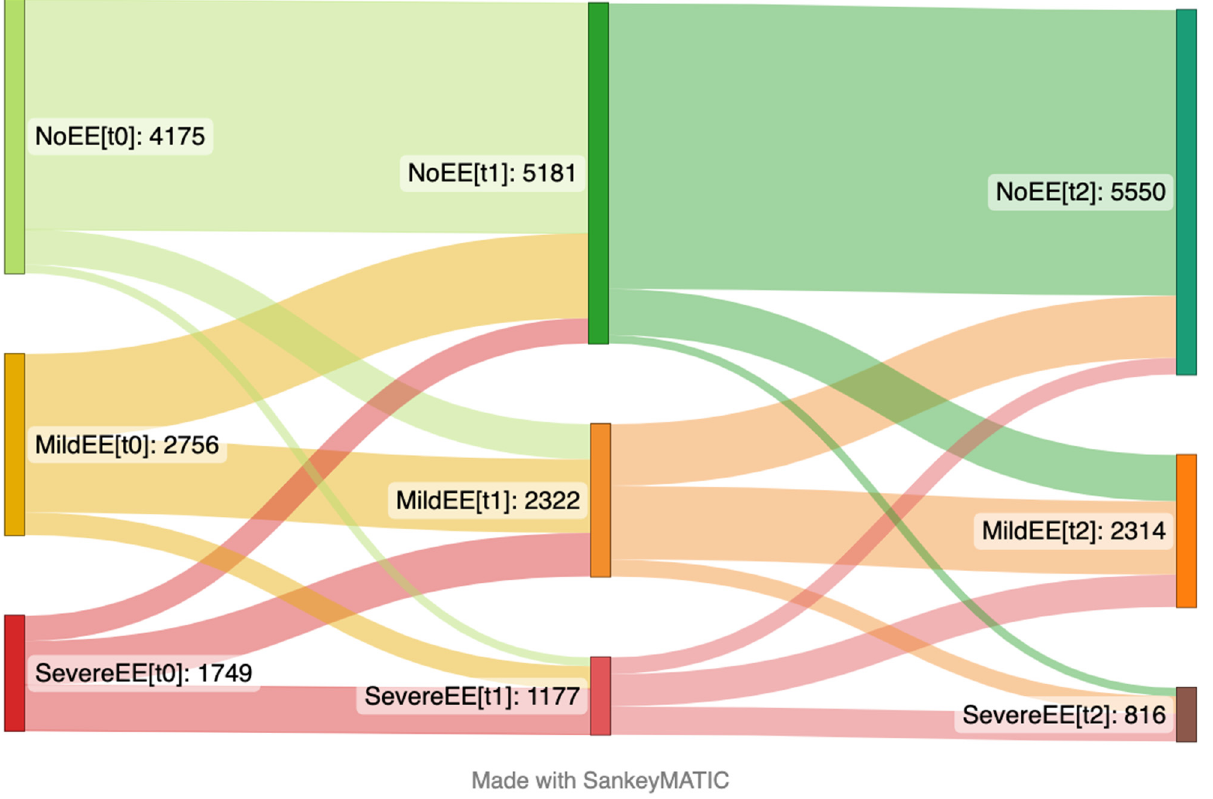
Figure 1. Sankey plot presenting changes in emotional eating over time from the April 2020 (left side) to January 2021 (center) and May 2022 (right side). The number in brackets represents time points. This plot includes the participants that answered the items focusing on emotional eating on the questionnaire at the first time point (t 0 ), second time point (t 1 ) and third time point (t 2 ) (n = 8453). Table 3. High-sugar food and drink intake and associations to psychological distress, worries and baseline characteristics (linear mixed model presenting absolute coefficients, with 0 indicating no difference/change, >0 indicating higher intake within group, and <0 indicating less intake within